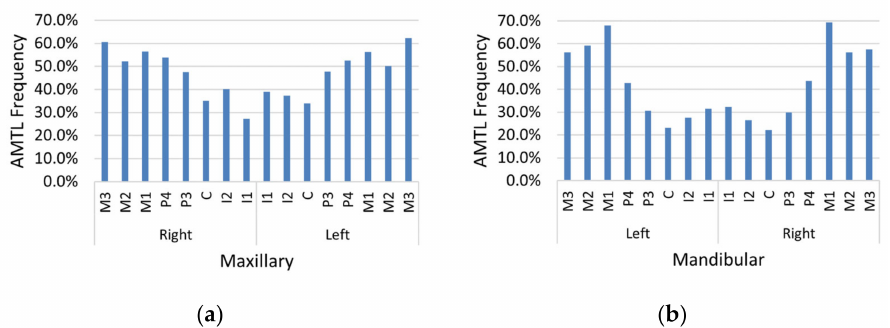
Figure 7. AMTL frequency for maxillary ( a ) and mandibular ( b )